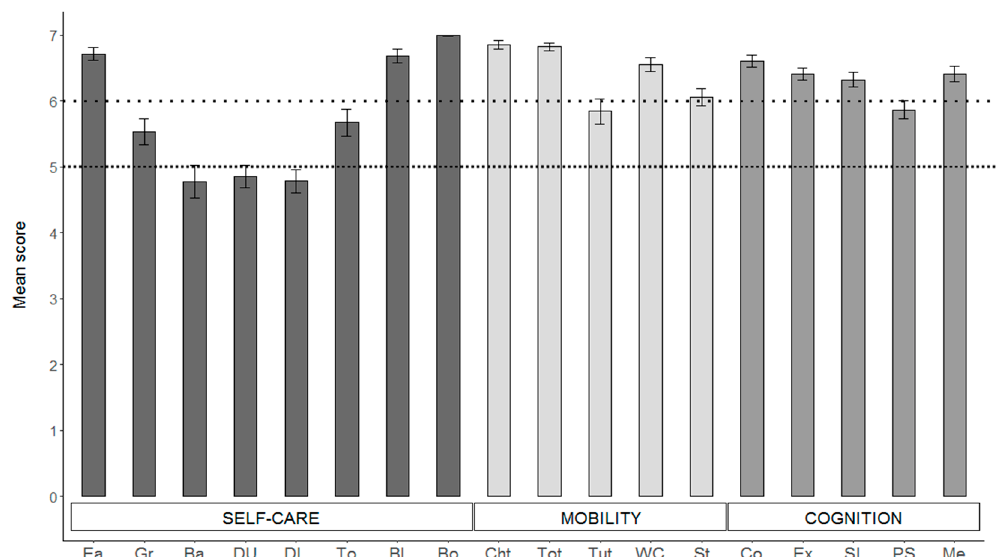
Figure 1. The nonlinear and linear relationships between the significant continuous predictors (time since diagnosis and the PS index) and the WeeFIM self-care, mobility, and cognition subscales. The shaded grey areas represent the SE.